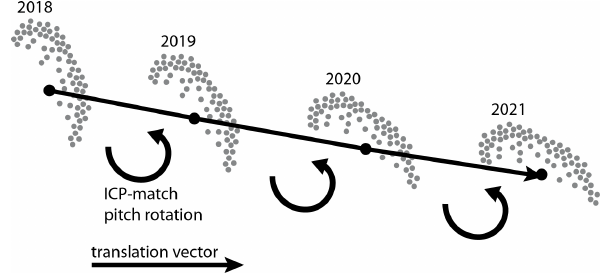
Figure 4. Principle of block shape matching in the ULS point clouds (grey dots) between consecutive time steps (2018–2021). The iterative closest point (ICP) algorithm was used to match the shape of a block in one epoch onto its shape in another epoch. A rotation in the opposite direction of the translation can be recog- nized for the block shapes. The figure shows examples of downs- lope translation and upslope